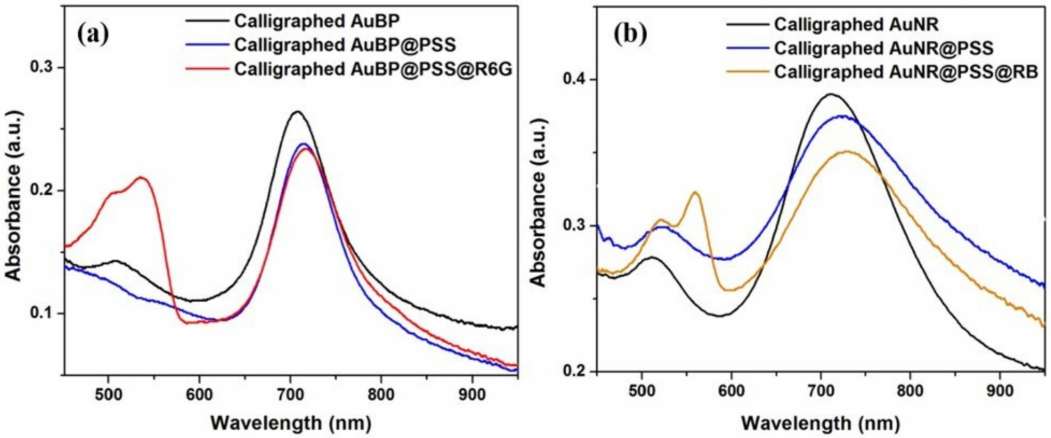
Figure 2. Extinction UV-Vis-NIR spectra of the as-calligraphed ( a ) AuBPs and ( b ) AuNRs lines (black spectra), functionalized with the negative PSS polyelectrolytes (blue spectra) and after the exposure to the cationic R6G (red spectrum) and anionic RB molecules (orange